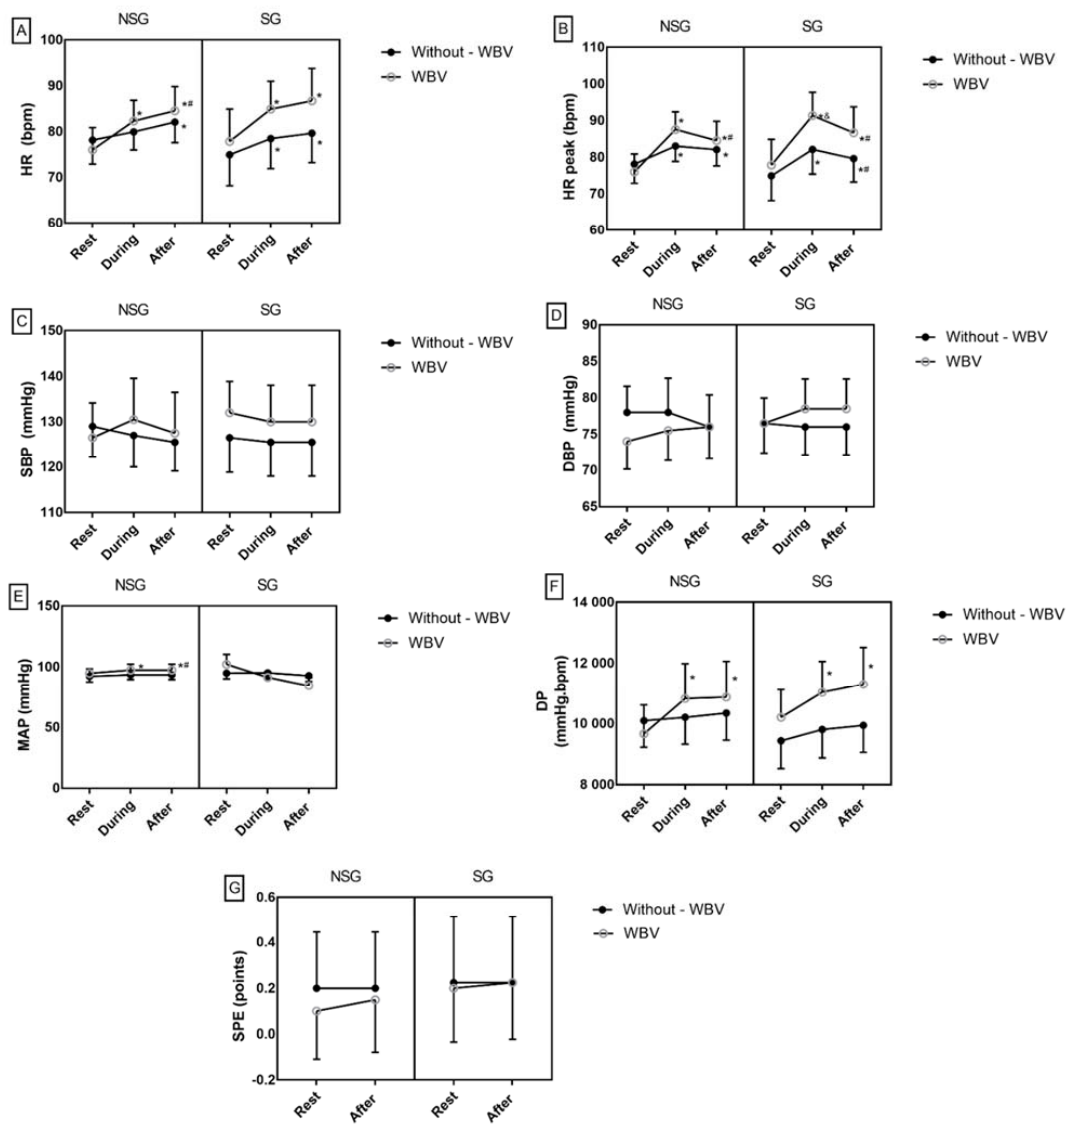
Figure 2. Immediate hemodynamic responses in the interventions with and without whole-body vibration in nonsarcopenic and sarcopenic groups. Data are means and standard deviation. Two-way ANOVA for repeated measures and post hoc Bonferroni. Significance * difference between “rest”; # difference between “during”, and & difference between WBV vs. without WBV ( p < 0.05). Difference between the mean values at rest between groups (a # b). ( A )—HR: heart rate; ( B )—peak HR; ( C )—Systolic Blood Pressure (SBP); ( D )—Diastolic Blood Pressure (DBP); ( E )—MAP: mean arterial pressure; ( F )—DP: double product; ( G )—SPE: subjective perception of effort.